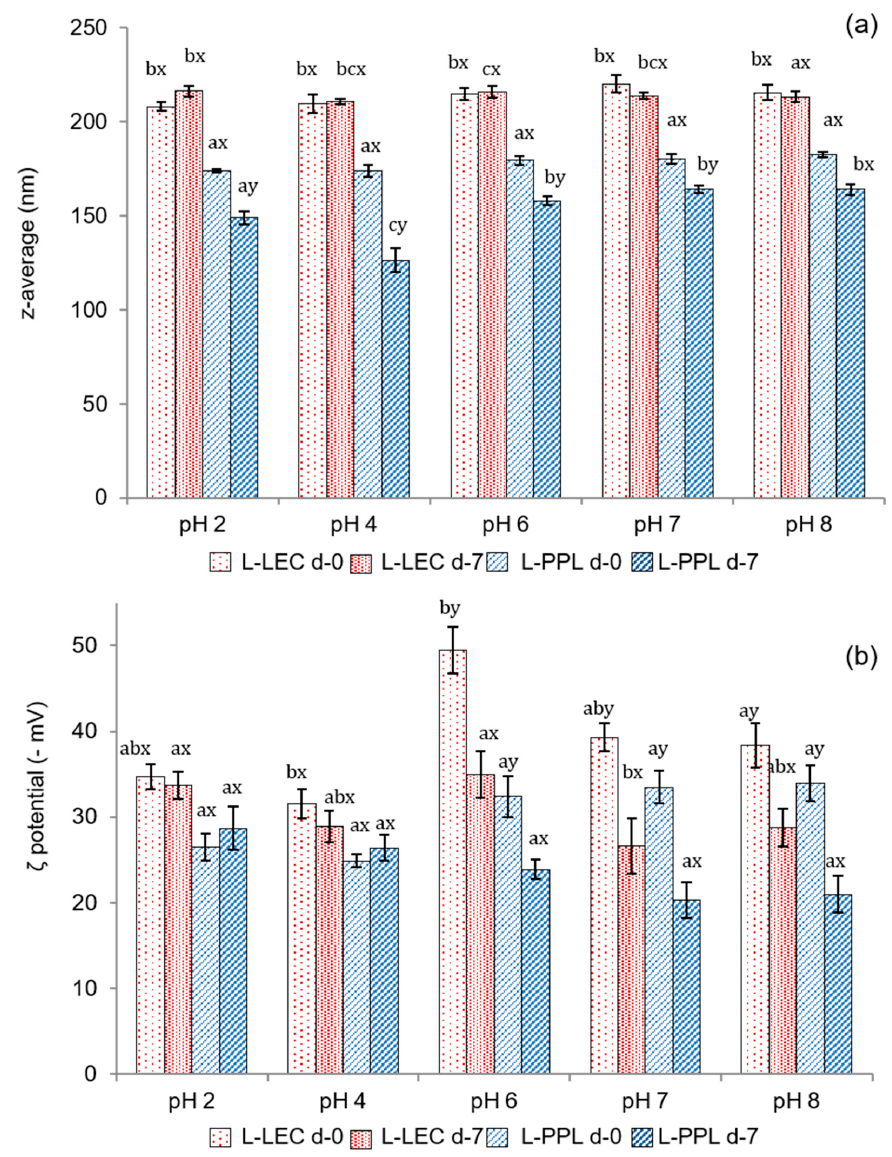
Figure 3. ( a ) Mean particle size (expressed as z-average, nm) and ( b ) ζ potential ( − mV) of newly prepared (d-0)